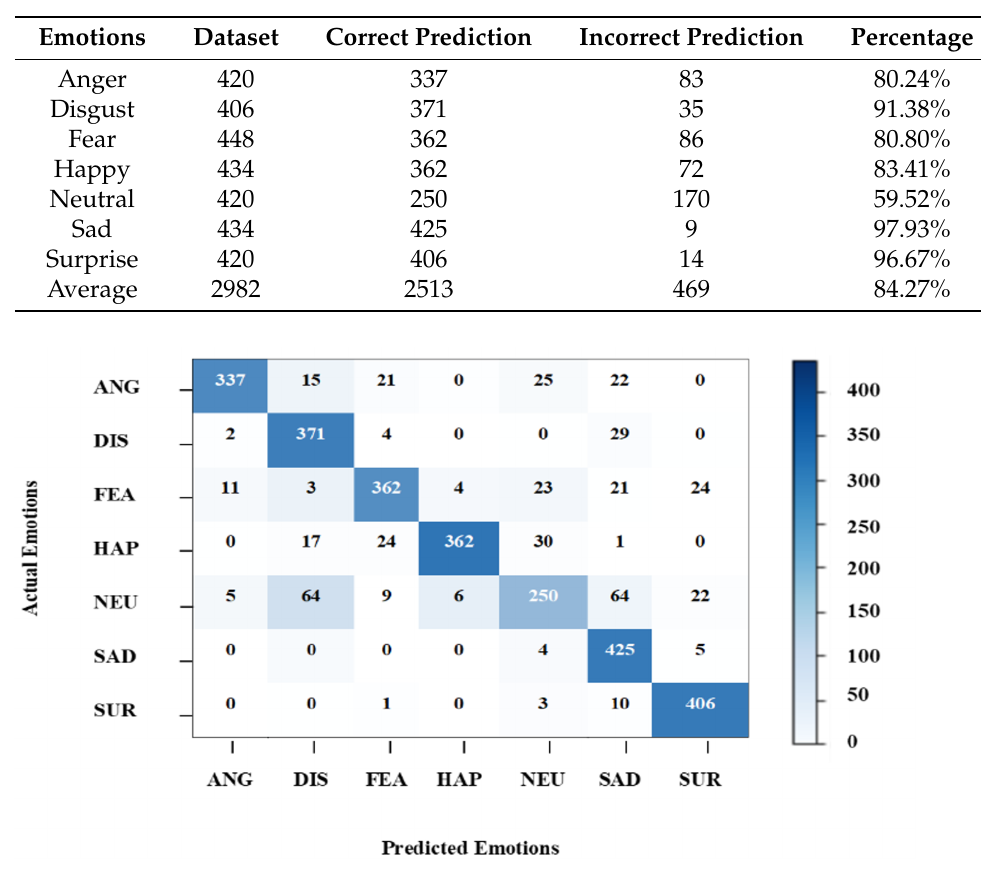
Figure 8. Confusion matrix of the proposed model performed with cross dataset after 10